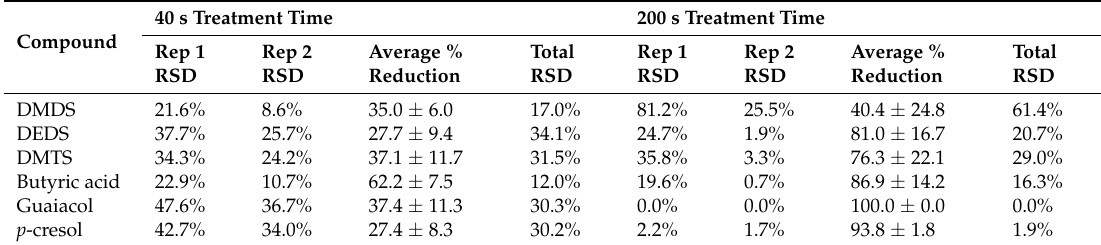
Table 3. Comparison of the % reduction to remove odorous compounds between two replicates of 10- µ g/cm 2 PureTi coating.